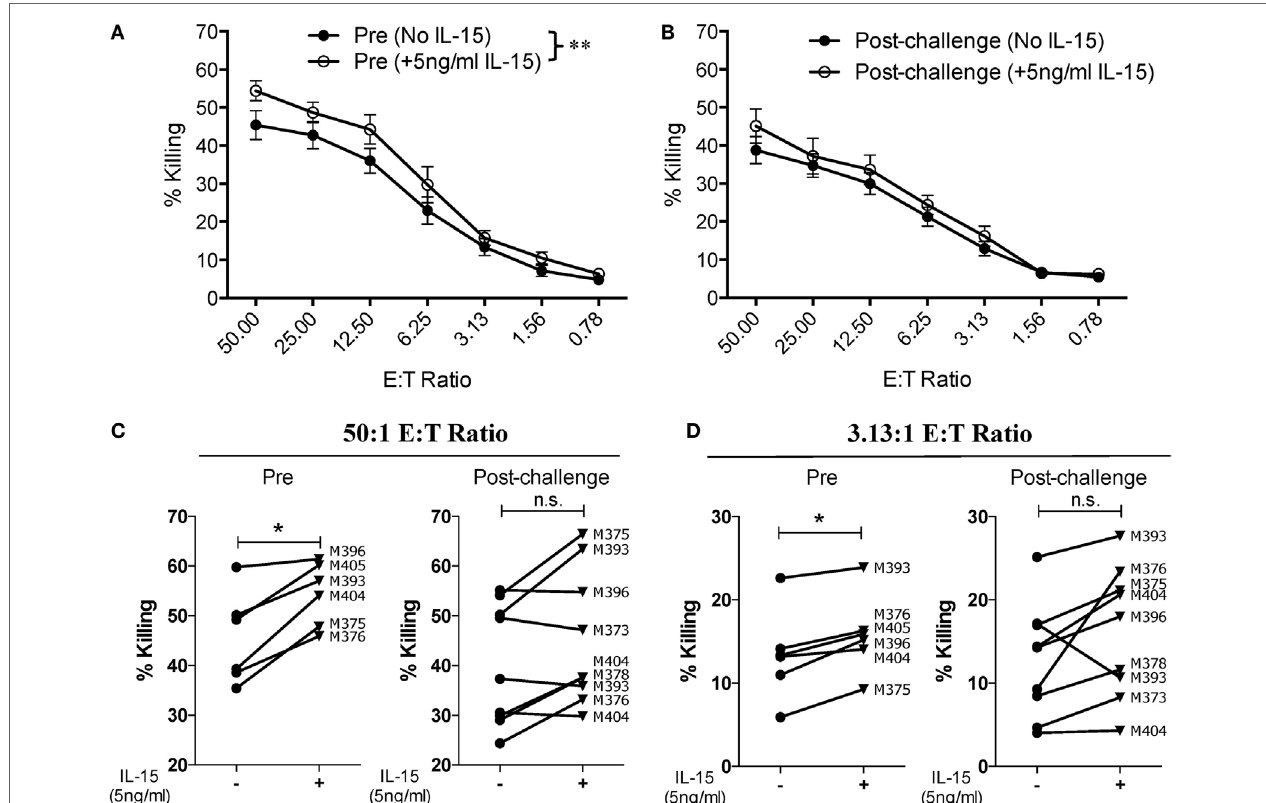
FigUre 3 | low dose of il-15 pre-treatment does not improve cytotoxic potential of nK cells from siV-infected macaques . Frozen PBMCs were thawed and cultured overnight in media alone or in media supplemented with 5 ng/ml of recombinant rhesus macaque IL-15 before being used in 721.221 killing assays. (a,B) Comparison of killing by PBMCs from pre-vaccination (a) and post-challenge (B) time-points. Data reported are means ± SEM. ** p < 0.01 indicates statistically significant differences between the indicated killing curves as determined by two-way ANOVA. (c,D) Impact of IL-15 pre-treatment on each type of effector cell at either a high [50:1 (c) ] or a low [3.13:1 (D) ] effector-to-target cell ratio. For these assays, six pre-vaccination samples were available and nine post-challenge samples were available (both weeks 8 and 12 post-challenge samples from macaque 393 were available). * p < 0.05 indicates statistically significant differences between the two compared conditions as determined by Wilcoxon matched-pairs signed-rank test. n.s., not